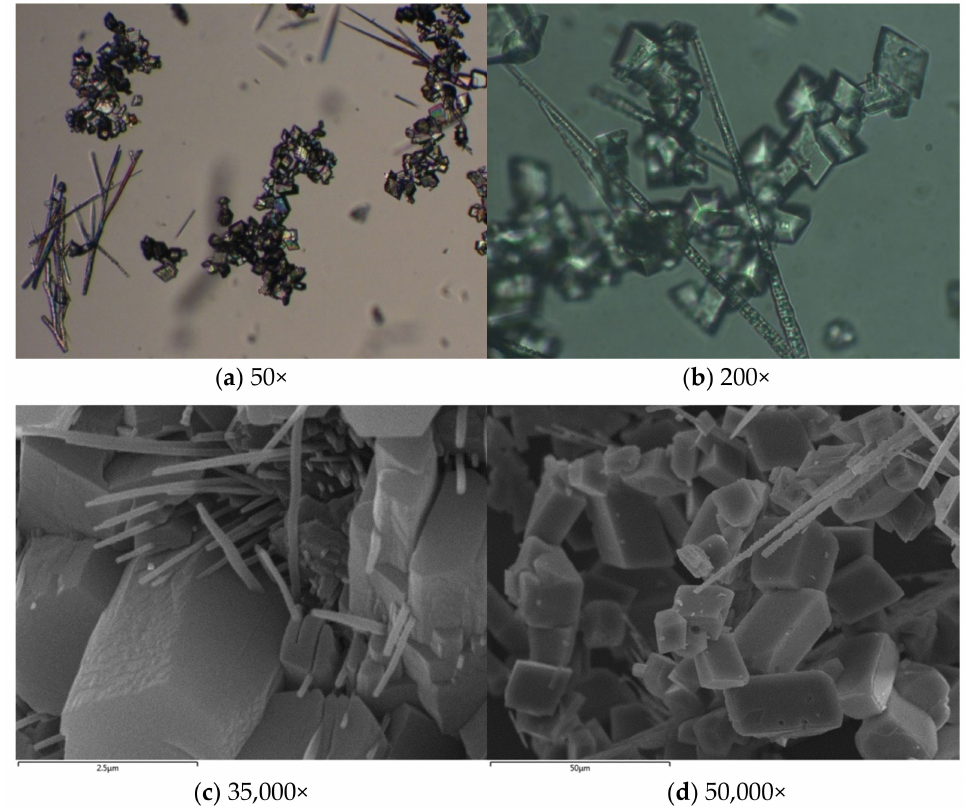
Figure 11. Optical and SEM images of the leachate at 7 days from a chemically stabilized soil samples additivated with MWCNTs (conc. = 0.01%) dispersed in a solution of Amber 2001 (conc. = 0.1%) with 7 curing days: ( a , b ) optical images and ( c , d ) SEM